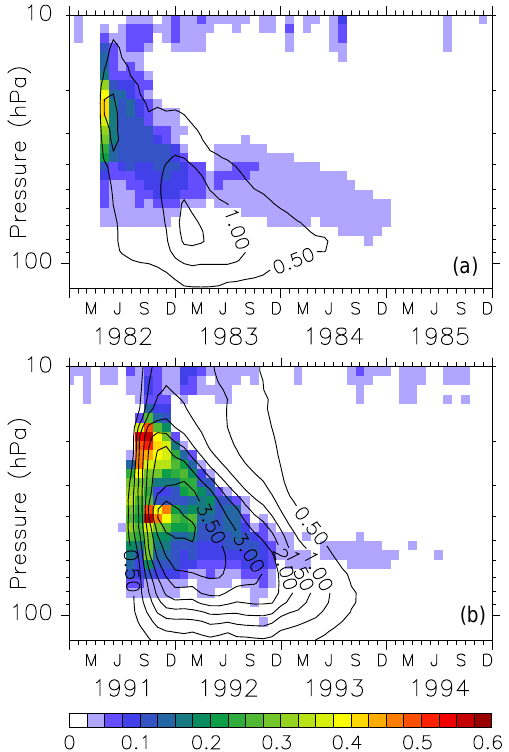
Figure 1. Zonally averaged heating rates (Kd − 1 ) as differences (VOL-NOVOL) in the tropics (5 ◦ S–5 ◦ N) for (a) the 1982 El Chichón and (b) the 1991 Mount Pinatubo eruption. Contours indi- cate absolute temperature changes (interval 0.5K) due to the heat- ing